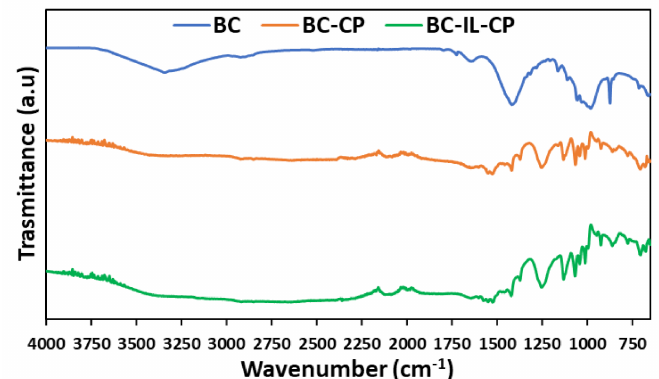
Figure 8. ATR-FTIR spectra of BC, BC-CP, and BC–IL-CP.